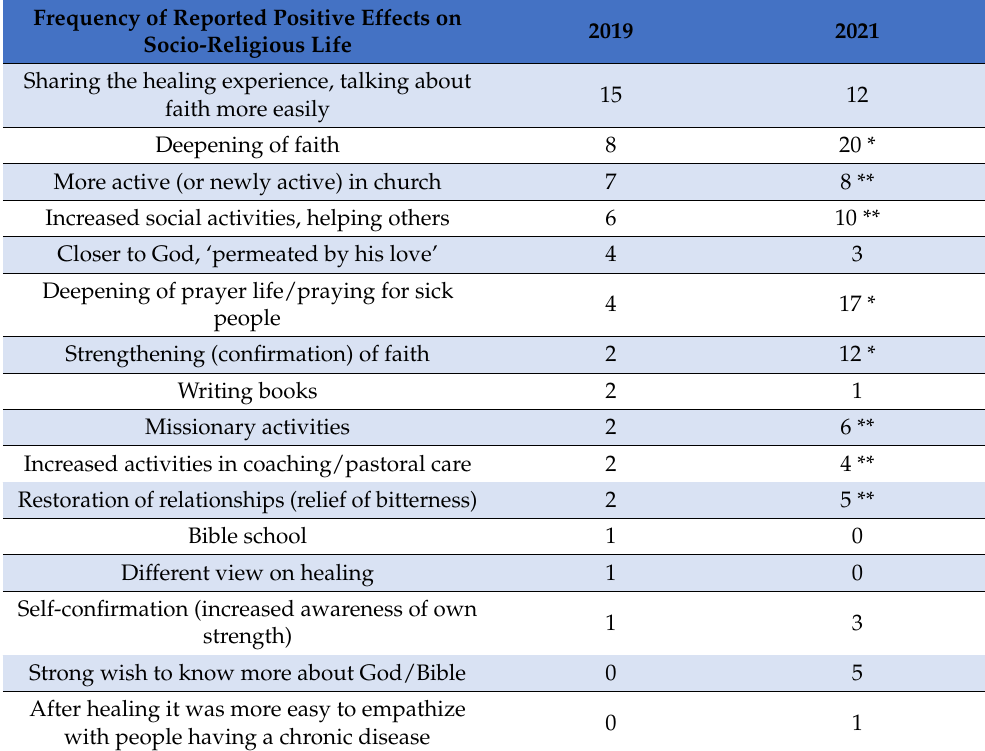
Table 15. positive effects mentioned on socio-religious